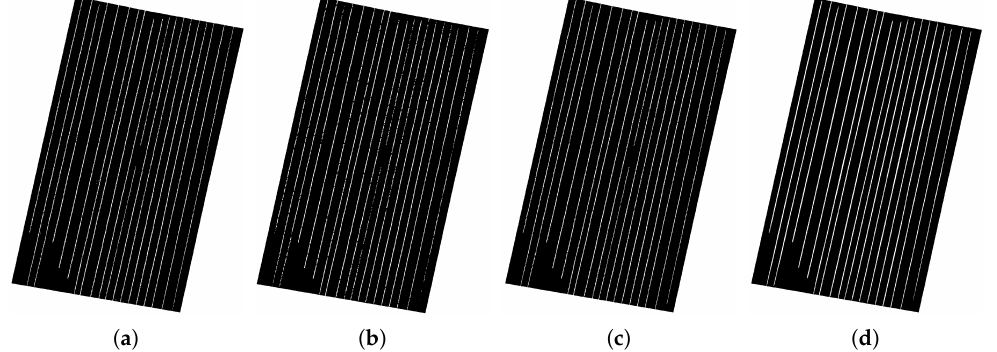
Figure 11. Final results using morphological operation. Ridge candidates are valued as 1 in white and non-ridge candidates are valued as 0 in black. ( a ) binary image ( f 4 ) after removing vegetation coverage of Plot 1, ( b ) result ( f 5 ) using image opening with MDSE, ( c ) result ( f 6 ) after removing small regions with threshold: 1000 pixels, ( d ) result ( f 7 ) using image closing with SEL.